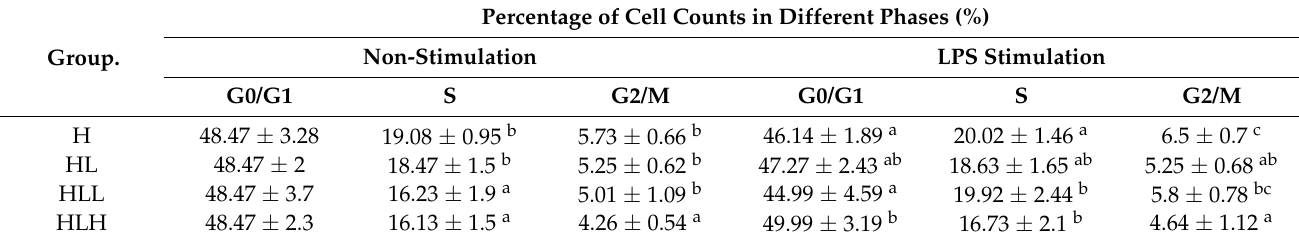
Table 3. Percentage cell counts in a different phase of the cell cycle.